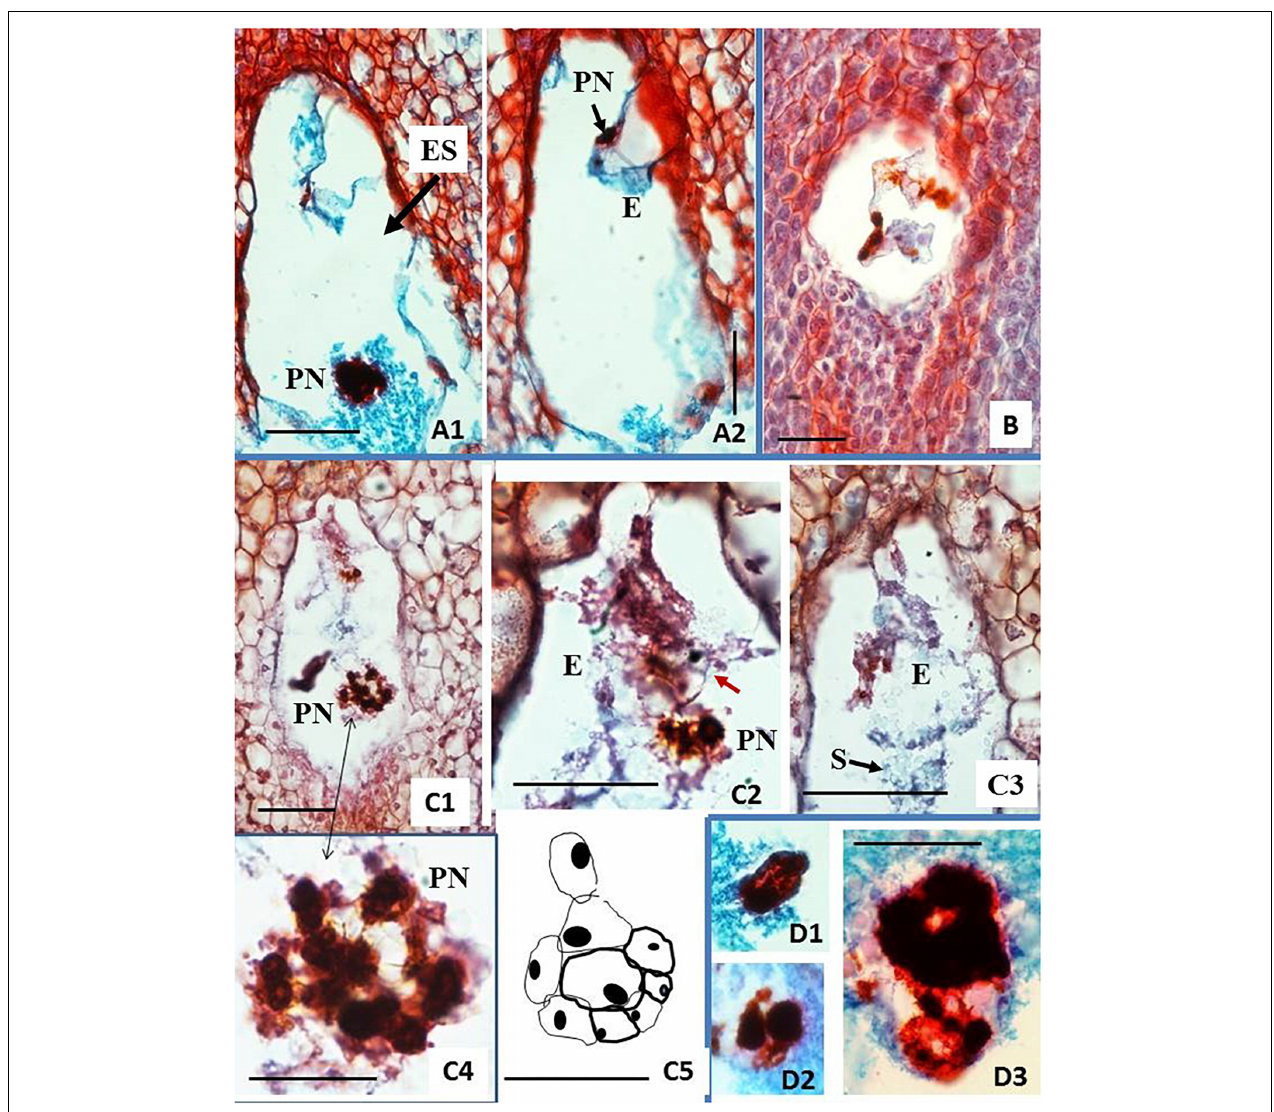
FIGURE 5 | Histological analysis of fixed, embedded, and sectioned unpollinated ovules from carpel cultures using Method C and single-step induction system. Sections of ovules cultured on solid BDS medium (A,B) or on solid F6 medium (C,D) for 6 weeks. (A1,A2) Embryo sac (ES) showing two-cell proembryo (E) at the micropylar (M) end and highly polyploid nucleus (PN) surrounded by dense cytoplasm at the chalazal end of ES. (B) Relatively small ES with three strongly stained nuclei lying in line and accompanied by cytoplasm containing starch grains. (C1–C5) ES containing a globular embryo and large groups of chromatic structures, probably polyploid nuclei. Epidermal layer of cells of the embryo is already differentiated. Red arrow in (C2) points at the embryo-epidermal layer of cells that can be seen of this section. The scheme drawn in (C5) is a representation of the whole embryo shown in (C2) . The embryo reconstruction was done by drawing the embryo cells walls, overlapping the images of the sequential sections containing this globular embryo. Dense clumps of starch (S) granules are clearly seen in (C3) , covering the globular embryo. Large chromatin structures are located at various positions of ES. Enlargement of the group of nuclei from (C1) shown in (C4) (doubled pointed black arrow) made chromatin bridges visible. (D1–D3) Show enlarged chromatin structures similar to those in (C1–C4) found in various other ES. Paraffin sections 8 µ m thick, stained with the Safranin O-Fast Green method. The bar equals 1 mm on (A1,A2,B,C1) , and 0.5 mm on (C2–5,D)